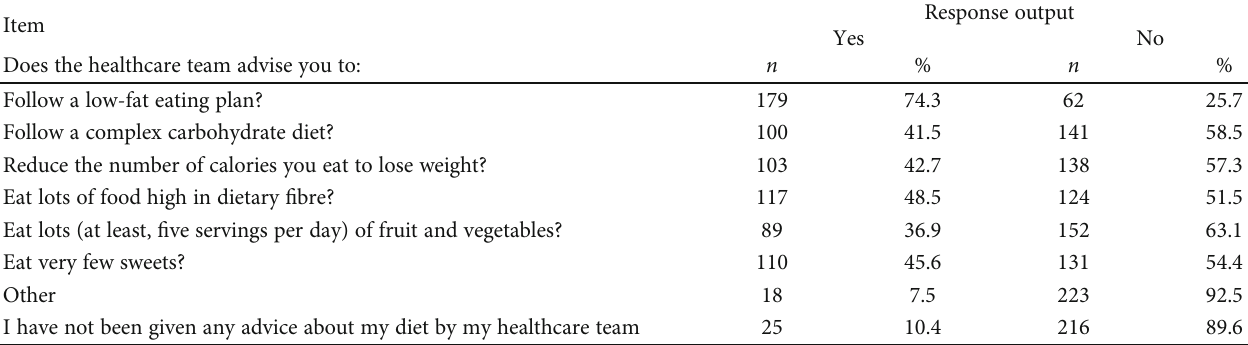
Table 3: Responses to the extended SDSCA survey diet domain.